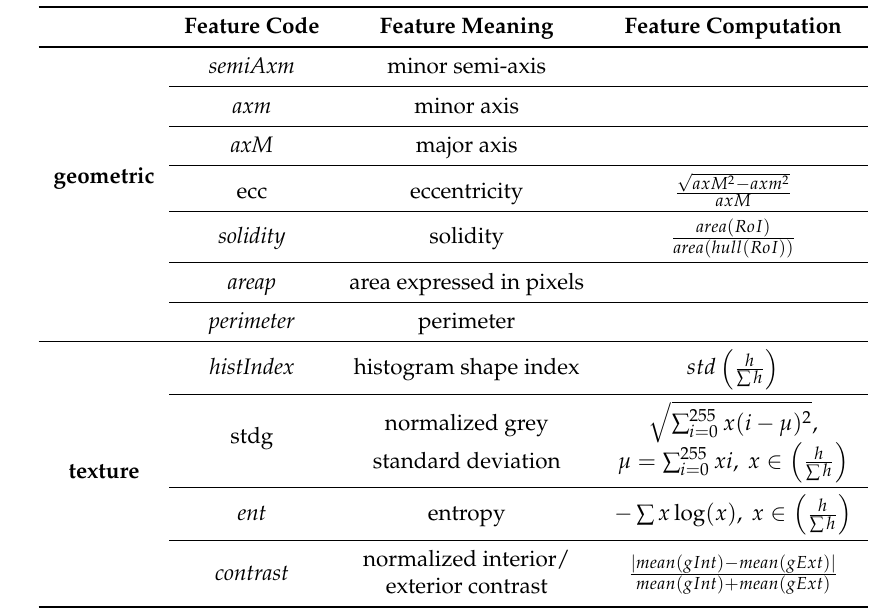
Table 2. Features extracted from each single image Region of Interest (RoI), where h is the histogram of the RoI grey level pixel